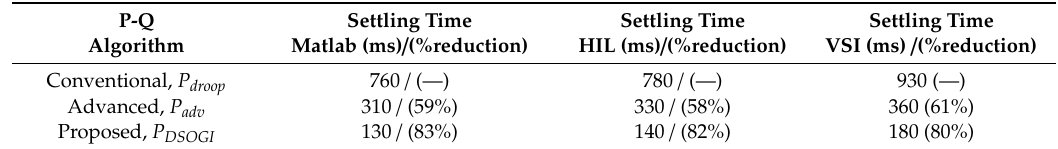
Table 5. Experimental results for the VSI Figure 19. VSI experimental result of the P droop transient response for the nonlinear DBR load current perturbation in Figure 18 ( P droop in green, P adv in blue, P DSOGI in red).